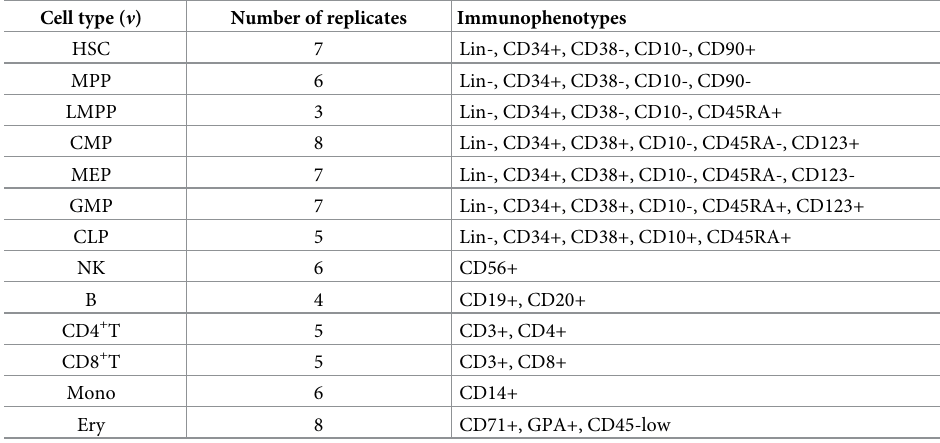
Table 1. Immunophenotypes of samples. Types of hematopoietic cells and their corresponding cell surface markers in [7]. For example, CD34+ and CD38- for cell type ν means that a cell of type ν expresses CD34 but not CD38 at its